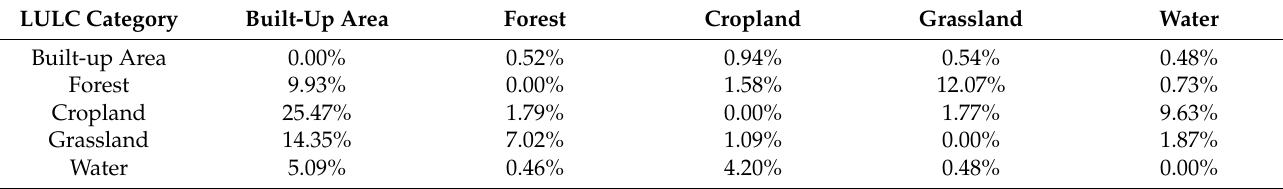
Table 5. Contribution of LULC categories to change.